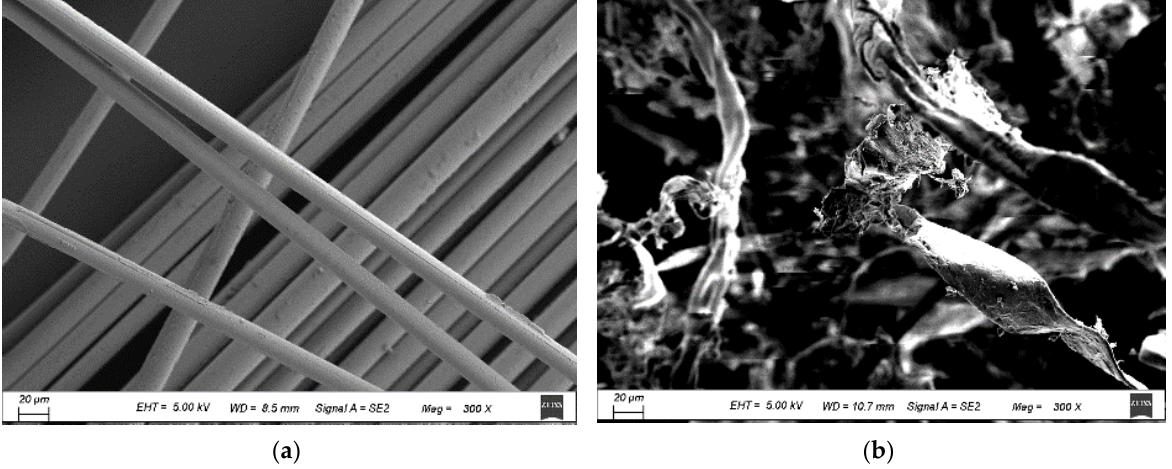
Figure 9. SEM images of fibers: ( a ) basalt fiber; ( b ) lignin fiber.